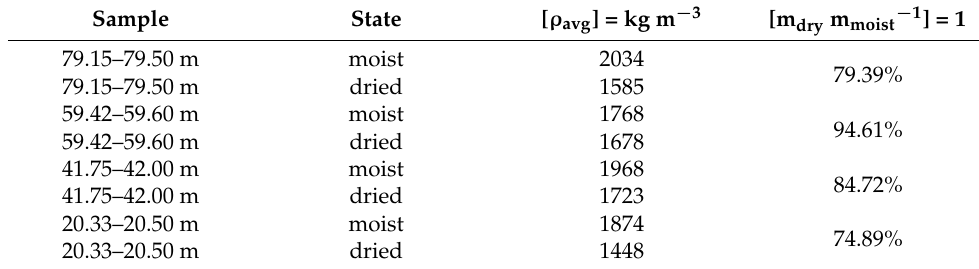
Table 4. Averaged densities before and after drying; relative mass change from moist